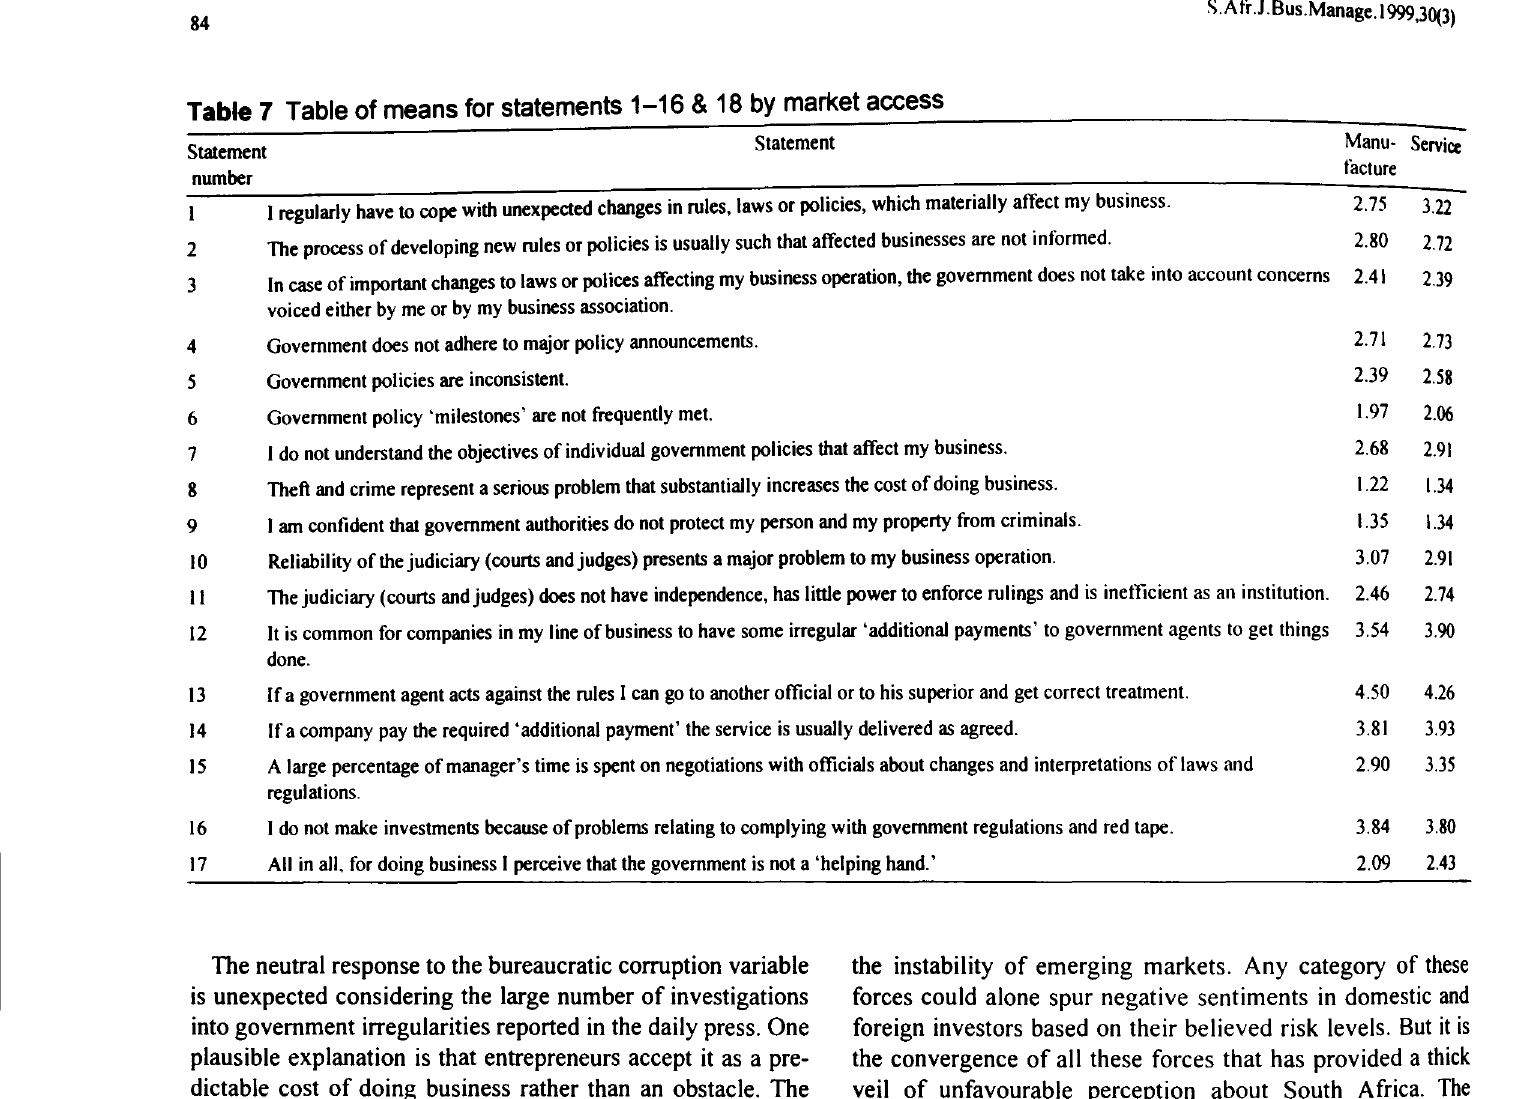
Table 7 Table of means for statements 1-16 & 18 by market